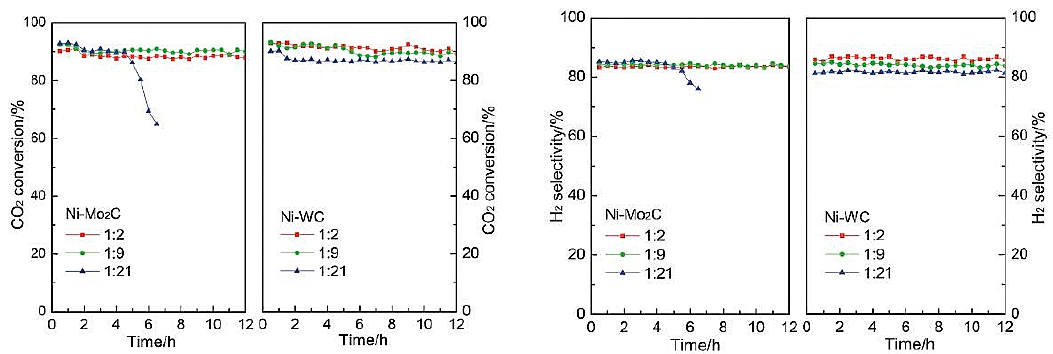
Figure 5. Lifetime study of the Ni-Mo 2 C and Ni-WC catalysts with various Ni / M (M = Mo and W) ratios in dry reforming of methane (DRM) (T = 800 ◦ C, P = 1 bar, CH 4 / CO 2 = 1, and weight hourly space velocity (WHSV) = 6000 cm 3 g − 1 h − 1 ) reproduced from reference [75] with permission from The Royal Society of Chemistry.